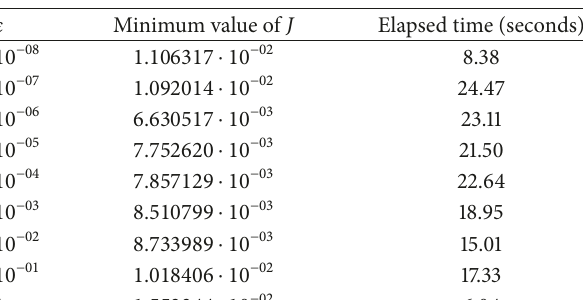
Table 1: Results on the Tikhonov approach. Comparison between different values of regularizing coefficient 𝜀 . The smallest value of 𝐽 is reached when 𝜀 = 10 −06 .